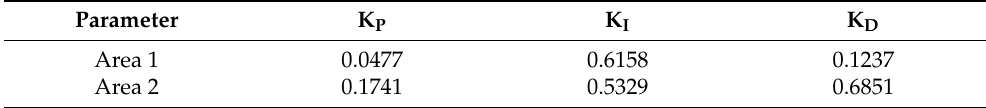
Table 10. PID controller parameters with a 0.4 delay.